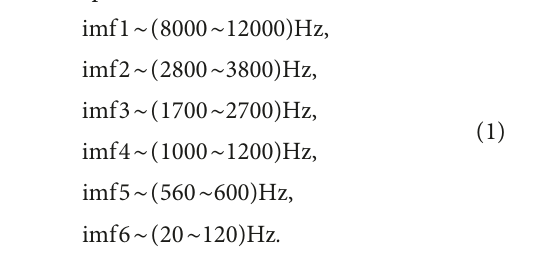
Table 2: Subjective evaluation score of each sample.